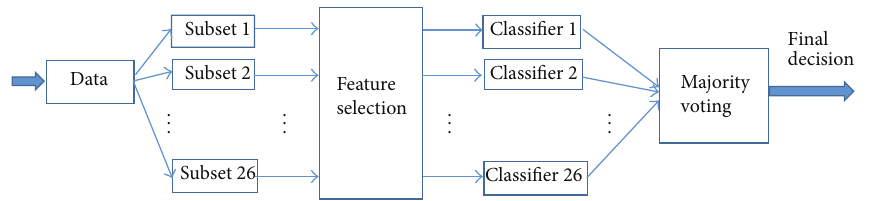
Figure 1: An illustration of the proposed method.